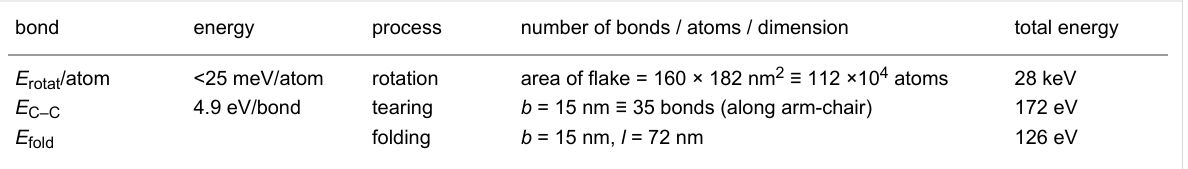
Table 1: Expenditure of energy in various processes.